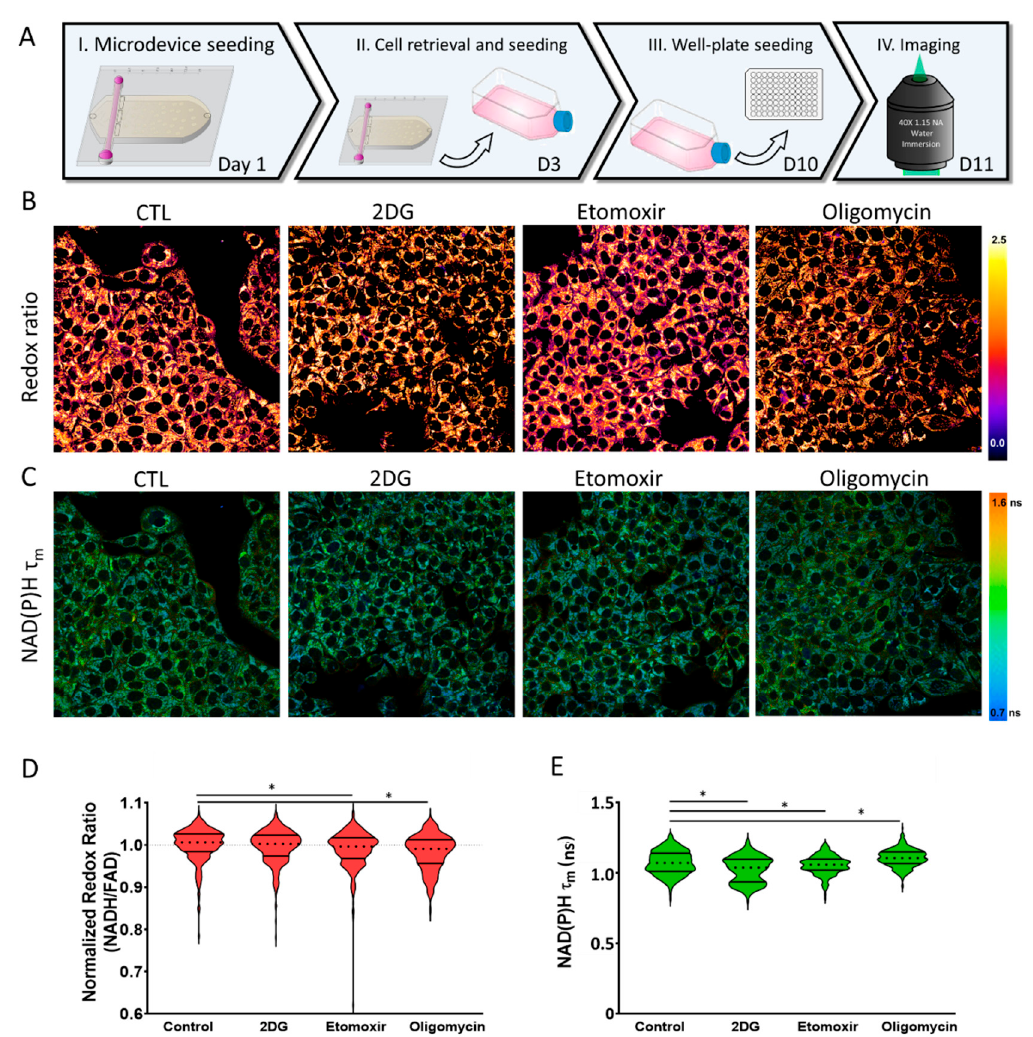
Figure 7. Metabolic analysis of recovered cells. ( A ) 15 million GFP-MCF7 cells/mL were cultured in the tumor-on-a-chip microdevice for 48 h in the presence of 2DG, etomoxir, or oligomycin. Next, cells were retrieved from the microdevice and cultured in a traditional Petri dish for 7 days in culture medium. 5000 MCF7 cells were reseeded on 96-well-plates and OMI was monitored after 24 h. ( B ) OMI multi-photon images showing the normalized optical redox ratio in the presence of culture medium (CTL), 2DG, etomoxir, or oligomycin. Images were normalized to the control (CTL). ( C ) OMI multi-photon images showing NAD(P)H τ m in the presence of culture medium (CTL), 2DG, etomoxir, or oligomycin. ( D , E ) Violin plots of the optical redox ratio normalized to the control condition, and NAD(P)H τ m across recovered cell conditions. * denotes p -value < 0.05.